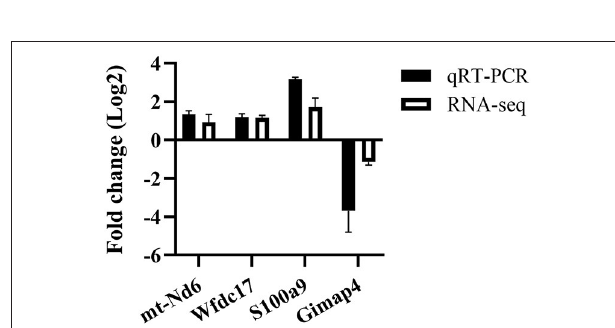
FIGURE 2 | qRT-PCR validation of randomly selected DEGs from the RNA-seq data. n = 3–5 mice per